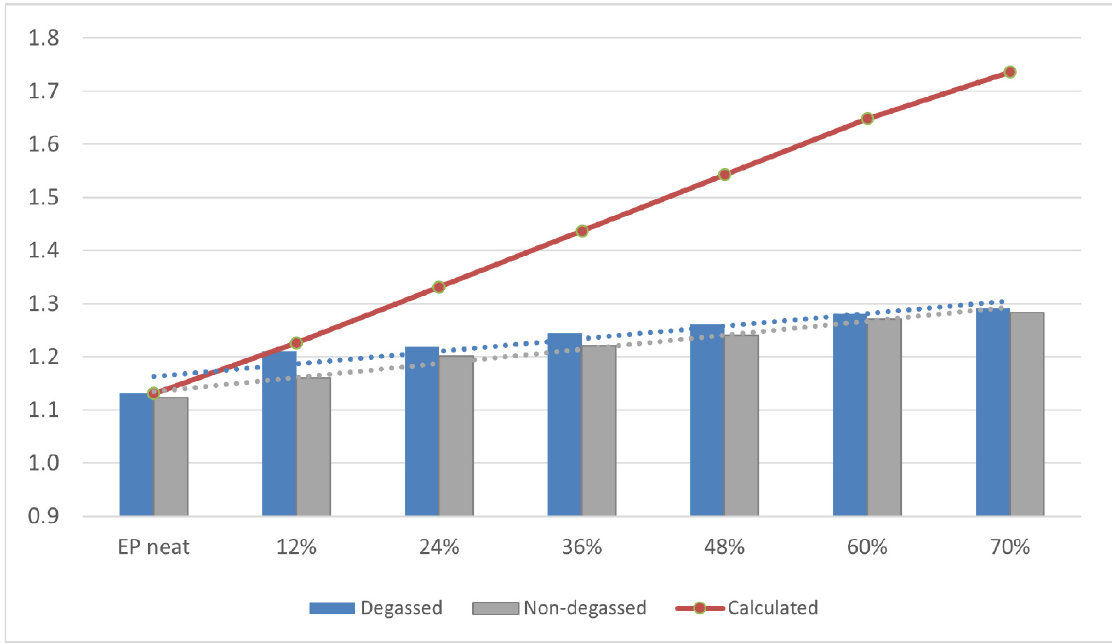
Figure 10. Density of degassed and non-degassed epoxy resin containing fractionated diatomite. An increase in density up to 1.3 g/cm 3 was also observed by [5], who used centric type diatom frustules as filler in an epoxy resin (degassing was applied) with a weight percentage of 15%. It has been observed that an increasing number of supplied fractionated diatoms went along with a linear growth in the density of composites obtained. Deviation from the theoretical value calculated for fully degassed composites with frustules completely filled with epoxy (Figures 9 and 10) arises from the fact that resin does not fully penetrate into the diatom structure and the nanostructure of the diatom frustule. We can also observe silica substructures present in frustule holes (Figure 4). Due to